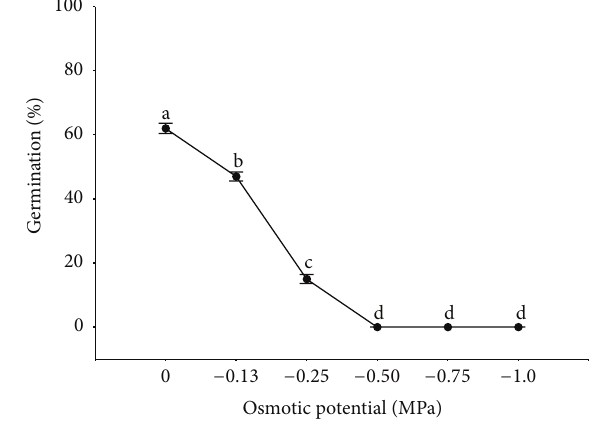
Figure 4: Mean germination percentages for Rumex confertus seeds at varying PEG-6000 solutions. Means ( 𝑛 = 4 ) with the same letter do not differ ( 𝑃 > 0.05 ). Error bars indicating standard